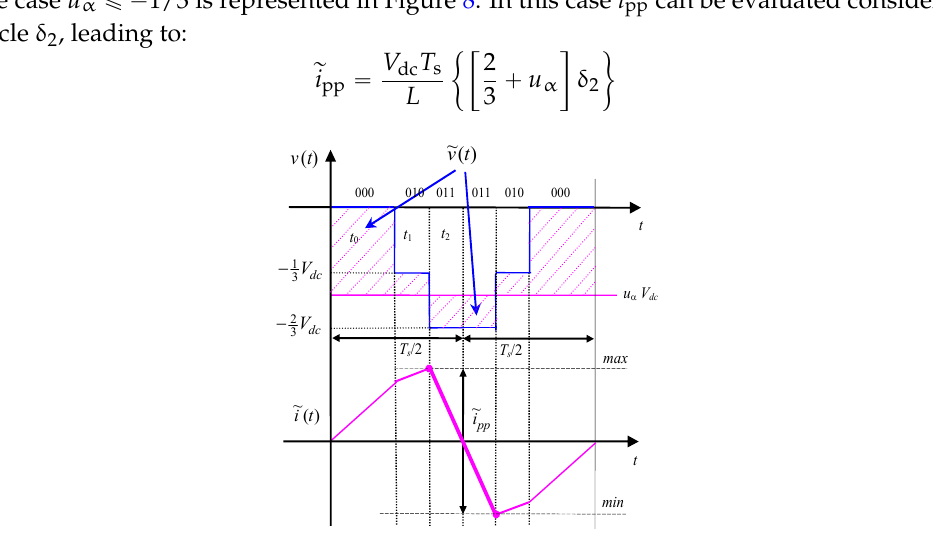
Figure 8. Output voltage and current ripple for DPWM − technique in one switching period (sector III, u α ≤ − 1/3).